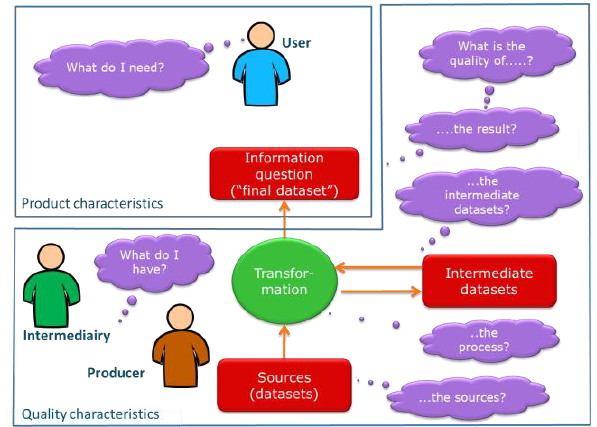
Figure 1: framework spatial data